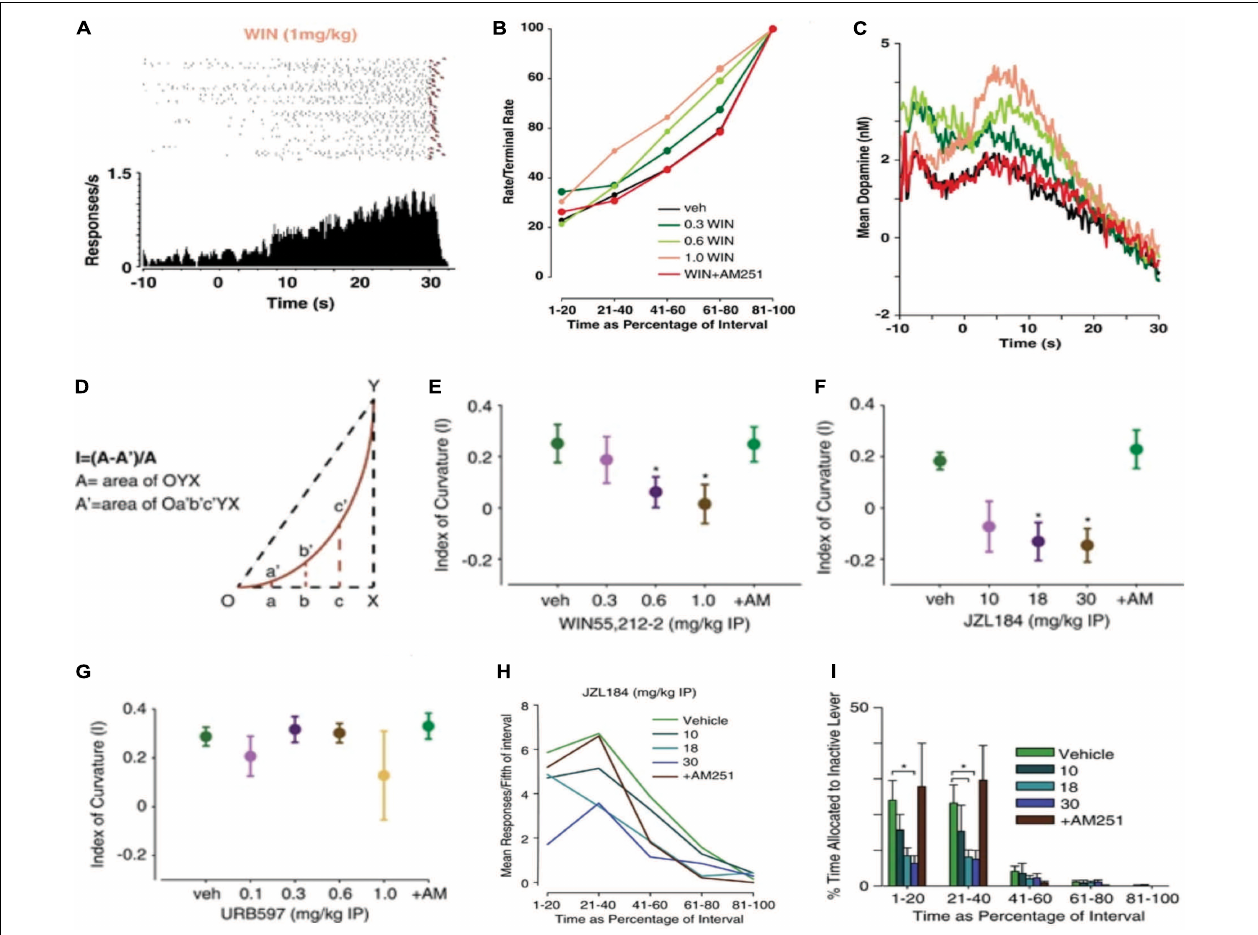
FIGURE 5 | Cannabinoids modulate a temporally engendered pattern DA release during reinforcement maintained under an FI schedule and adjunctive behavior. An illustrative cumulative response pattern (top: raster plots; bottom: corresponding peri-event histograms) of a WIN-treated mouse responding for food reinforcement under a FI schedule. The pattern of lever pressing lawfully increases in the FI task to form a scalloped response pattern. The raster plot shows responses (black ticks) preceding food reinforcement (red triangle) across the 30 s interval. All trials are shown in chronological order as they occurred in a representative experimental session. The peri-event histogram shows the summation of responding under each corresponding raster plot. (A) . WIN 55,212-2 accelerated the timing of scallop response pattern in a dose- and CB1-dependent manner. Mean behavioral response patterns following cannabinoid administration are plotted as a function of the interval duration (B) . WIN amplified a temporally engendered pattern of DA release in a dose- and CB1-dependent manner. Mean DA concentration traces for each drug treatment conditions are plotted as a function of the interval (C) . Cannabinoid-induced changes in interval timing were quantified by assessing the index